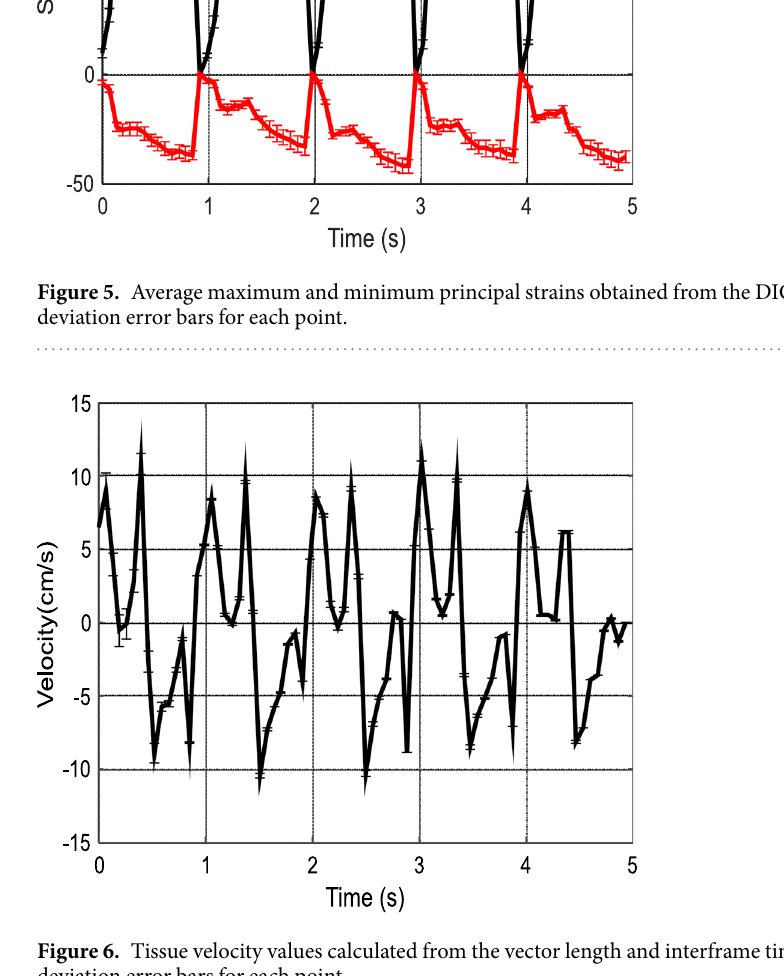
The tissue velocity can be calculated from the displacement data obtained at a known frequency by dividing the change in the length of the displacement vector by the interframe time. Figure 6 shows the average tissue velocity obtained from the black rectangle area depicted in Fig. 3. The tissue velocity varies between + 10 and − 10 cm/s, and each pulse reveals the same overall shape characteristics with minor scatter in the velocity values. Conventionally in the medical field, various characteristic points are observered in the tissue velocity vs. time graphs. The most useful or most important points include peak systolic tissue velocity (TV s ), peak early diastolic tissue velocity (TV e ), and peak late diastolic tissue velocity (TV a ). Figure 7 shows the DIC measurements as a close-up of Fig. 6. The overall shape of the graph and the values are in good accordance with the tissue veclovity values determined by TDI found in literture and used as reference in the clinical routines 29 . There are various naming conventoions used in the medical field to denote the charactaristic points in the tissue velocity vs time graph, here we use the follwing where TV e is the maximum value of velocity in the negative direction, which is by convention the movement away from the apex. A local maximum negative velocity value (TV a ) is found between TV e and the maximum positive (towards the apex) velocity value, denoted as TV s . DIC Fractional shortening. Fractional shortening (FS) is routinely used for the assessment of the ability of the heart to pump blood into the circulation. Fractional shortening is the relative change in the length of a